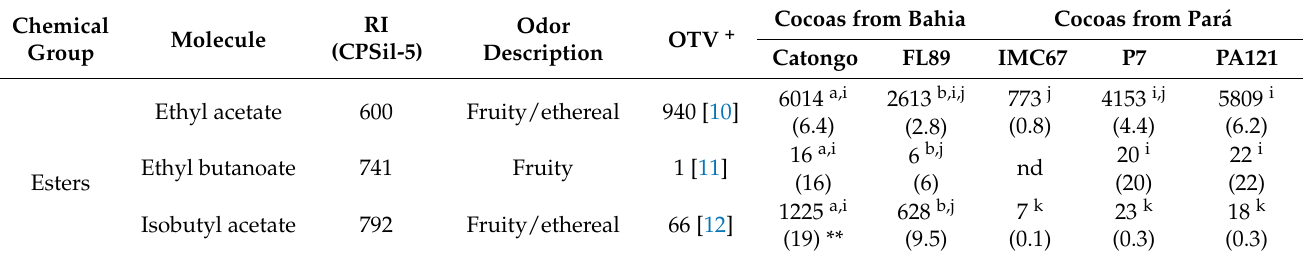
Table 1. GC-EIMS quantification of volatile aroma compounds characteristic of Catongo. Concentra- tions given in µ g/kg and followed by Odor Activity Values (OAV) in